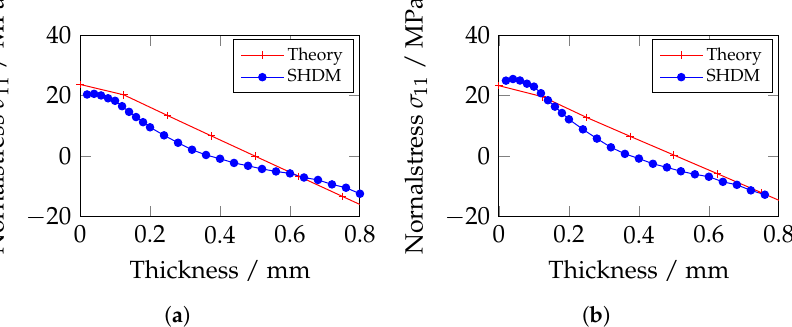
Figure 6. Comparison of the theoretical residual stress and the predicted residual stress state using the simulated hole drilling method for the in-plane waviness. ( a ) Sinus D1; ( b ) Sinus